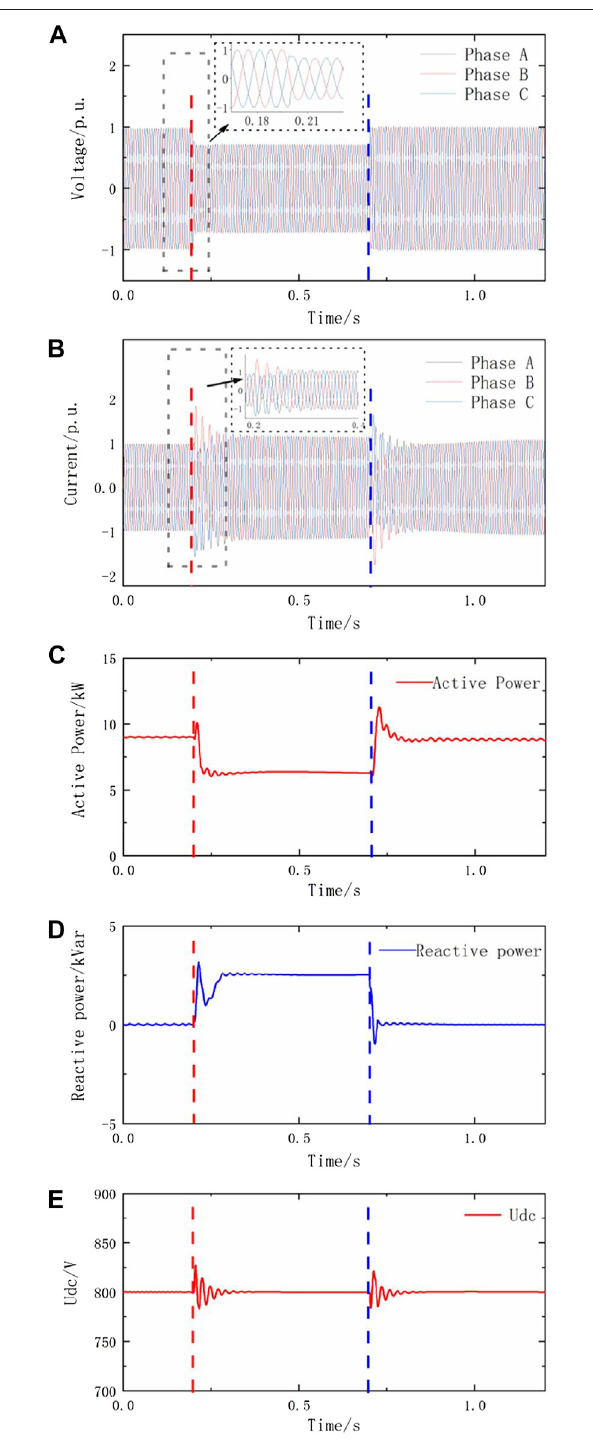
FIGURE 4 | Results of control simulation when a slight voltage drops to 70%. (A – E) power Q and DC bus voltage U dc .